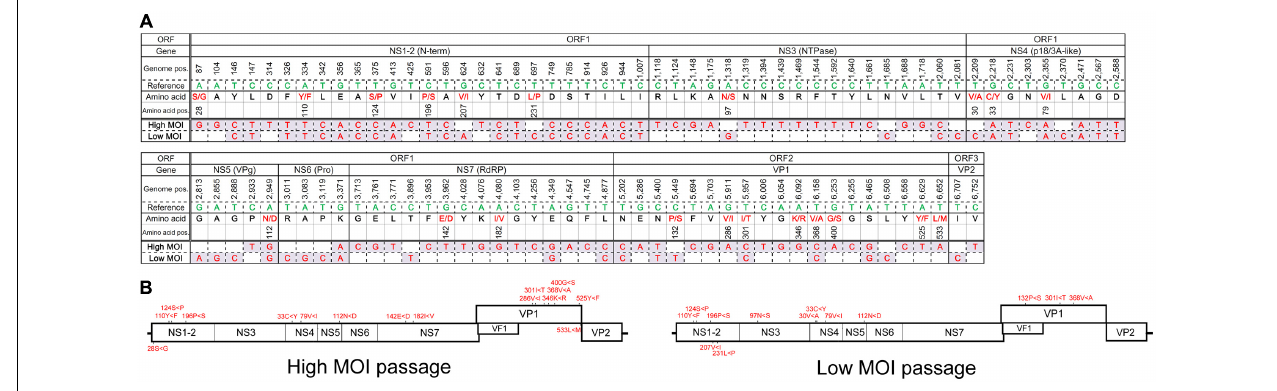
FIGURE 3 | Major haplotype sequences found following the final high- or low-MOI passage. (A) Sequence of the major haplotype following the final high- and low-MOI passages. Nucleotides that differed from those found in the PP3 (Reference) sequence are shown along with their genome position (Genome pos.) and the encoded amino acid residue (Amino acid) and their position (Amino acid pos.) in the PP3- or PP2-encoded protein, respectively. Non-synonymous changes are depicted in red. (B) Non-synonymous changes of each major haplotype are depicted in the MuNoV genome. Amino acid changes are described similar to those in Figure 2 .